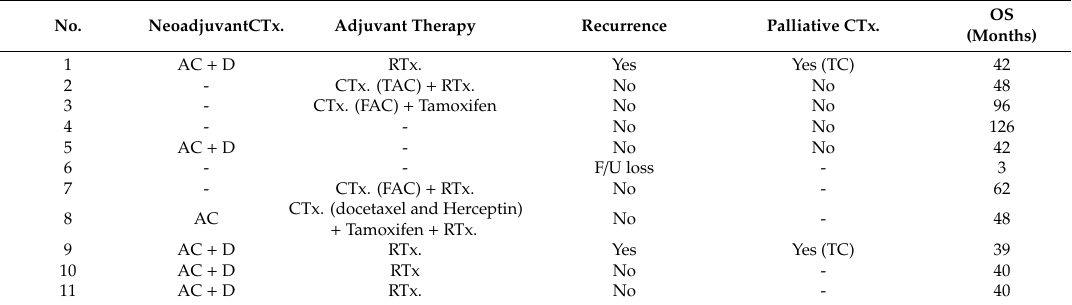
Table 3. Treatment outcomes of patients with pathogenic mutations in both gBRCA1 and gBRCA2 and patients who had a gBRCA1 mutation and gBRCA2